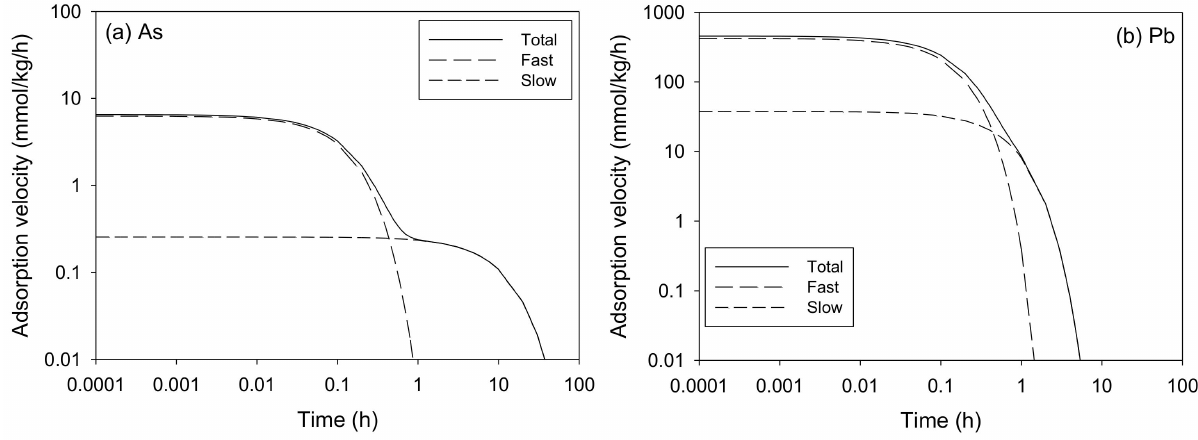
Figure 8. Analysis of the fast and slow adsorption velocity from MTCFOKM with semi-log scale: ( a ) As and ( b )